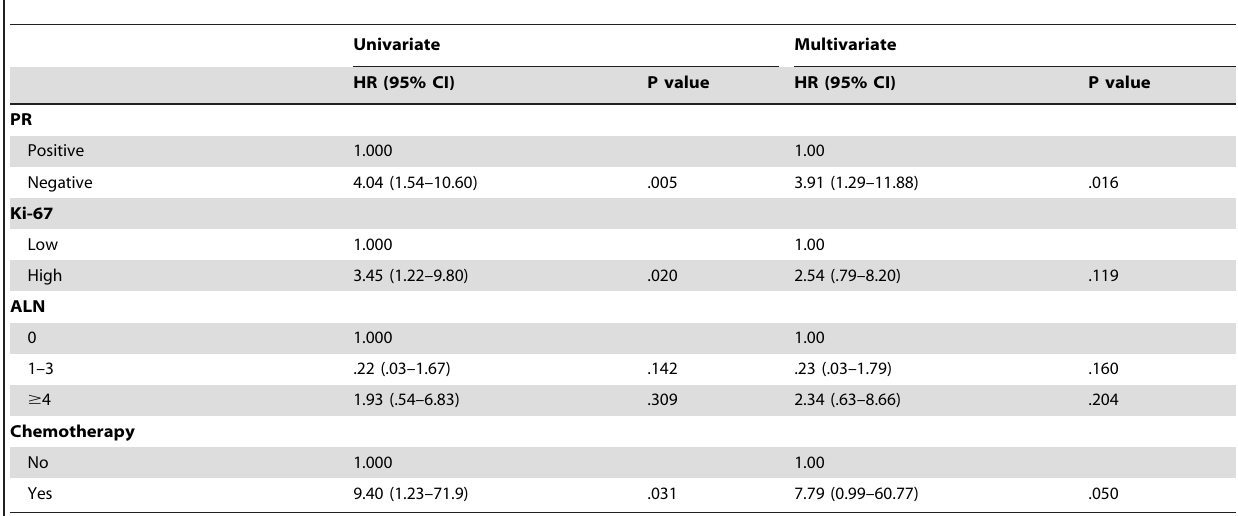
Table 3. Multivariate Cox proportional Hazards regression model results in Luminal B/HER2-negative tumors.